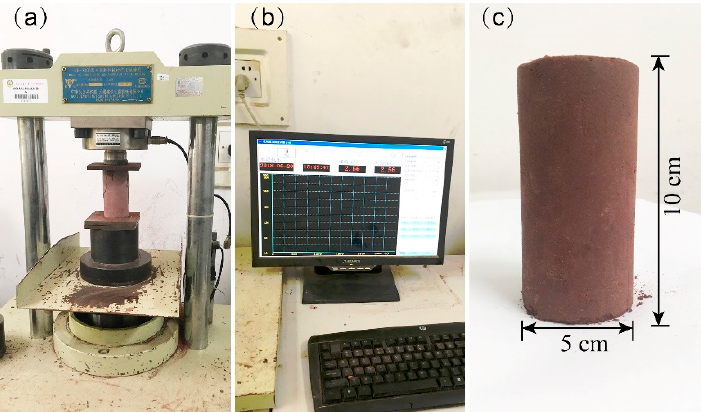
Figure 1. The TYE-300D and sample. ( a ) The TYE-300D test instrument; ( b ) the experiment bench; ( c ) the sample.